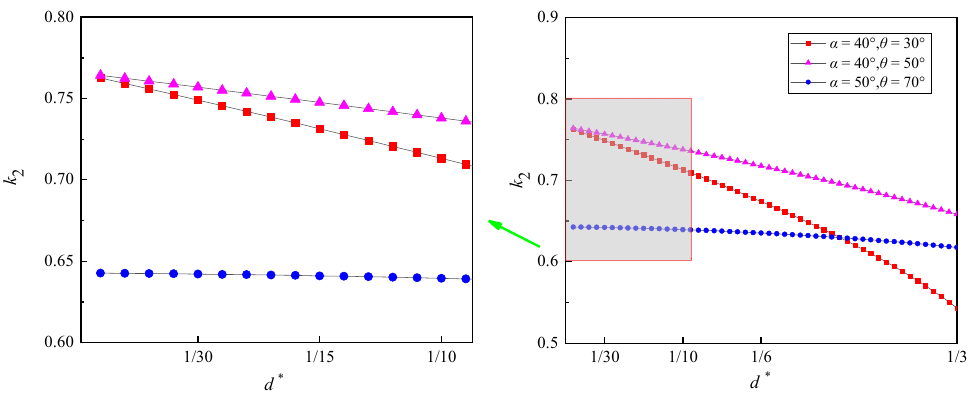
Figure 4. Relationship between d * and the corrected coefficient k 2 .